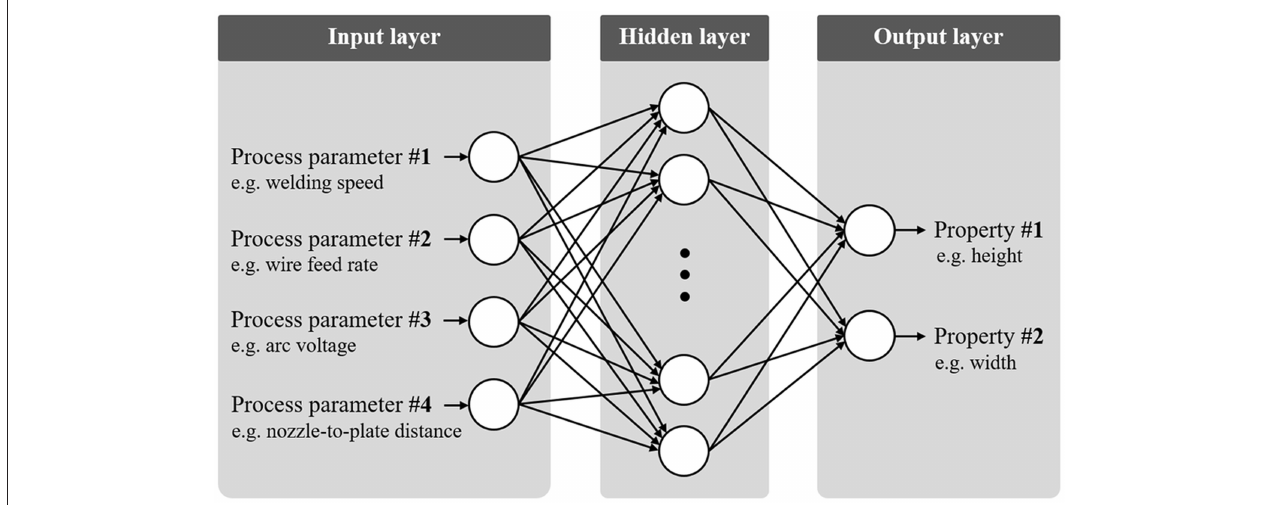
FIGURE 2 | Illustration of a fully connected three-layered feedforward artificial neural network, with the ability to approximate non-linear processes, here, in particular, linking process parameters of the additive manufacturing process of robotic gas metal arc welding as inputs to their resulting outputs: height and width of deposited bead layer. Own figure based on the idea presented by Xiong et al.